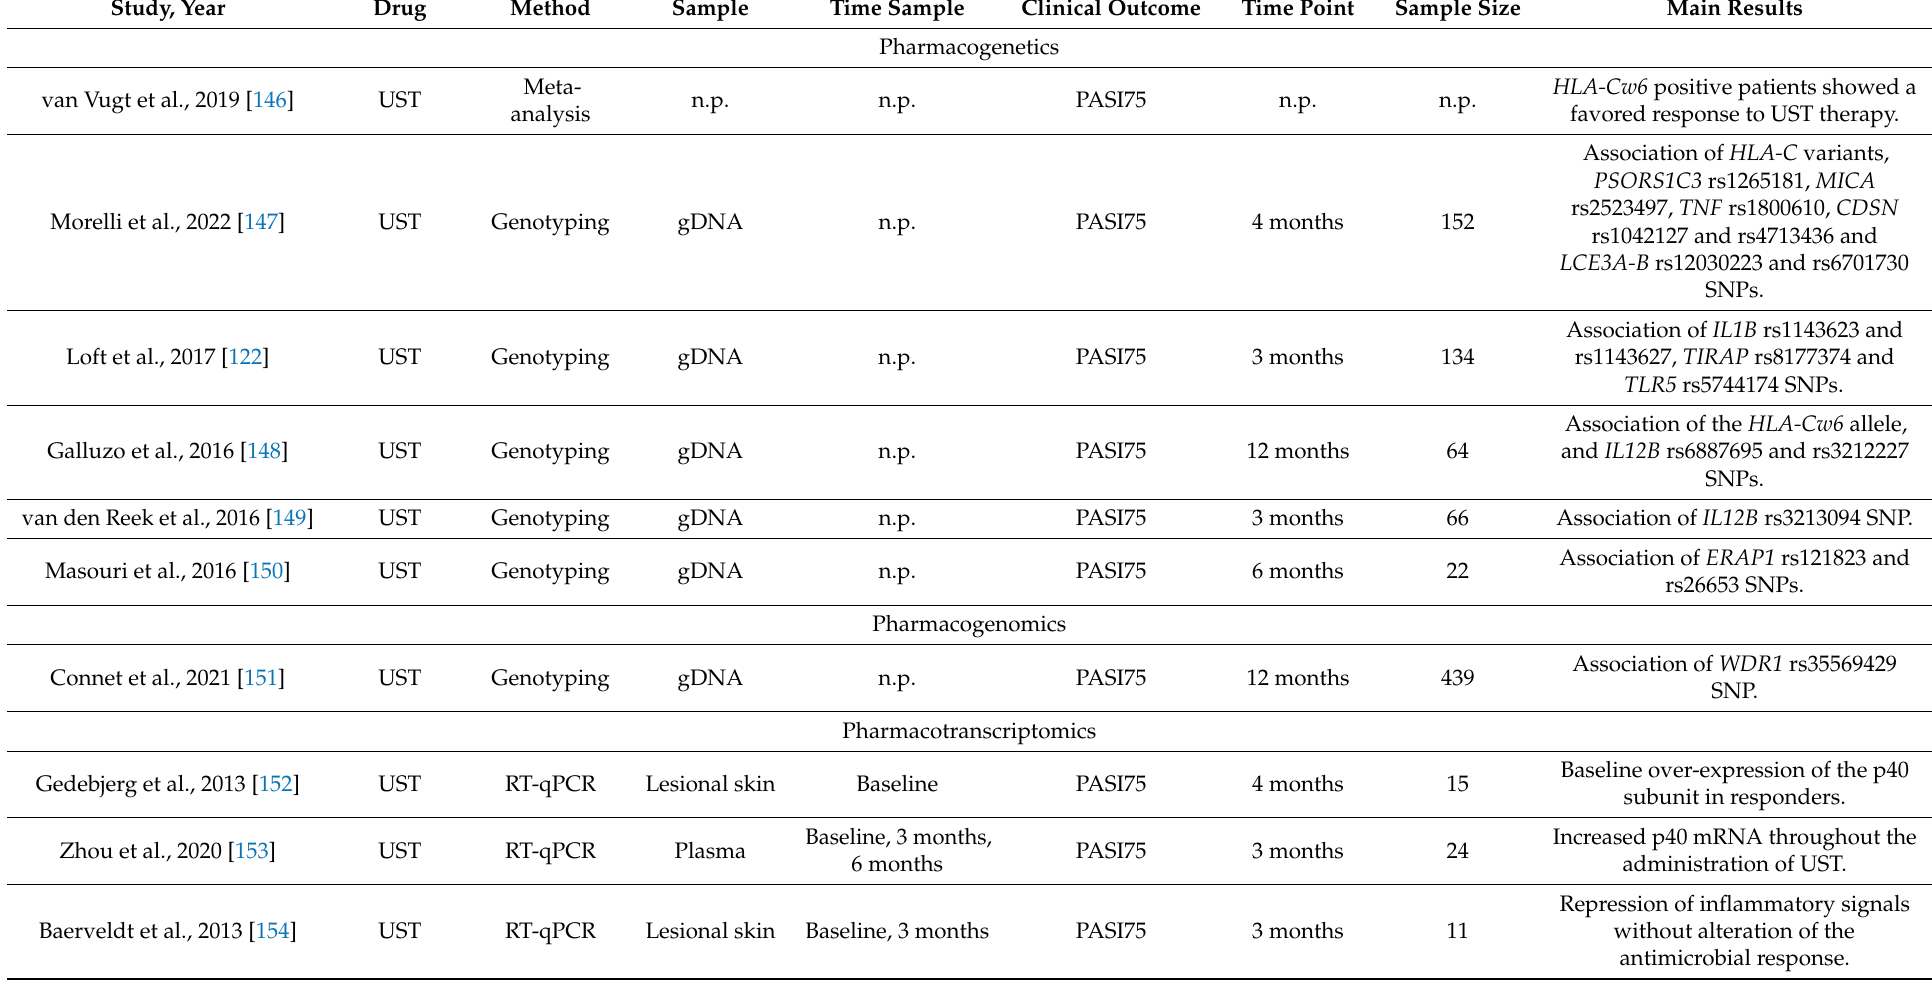
Table 4. Pharmaco-omic approaches applied in anti-IL23